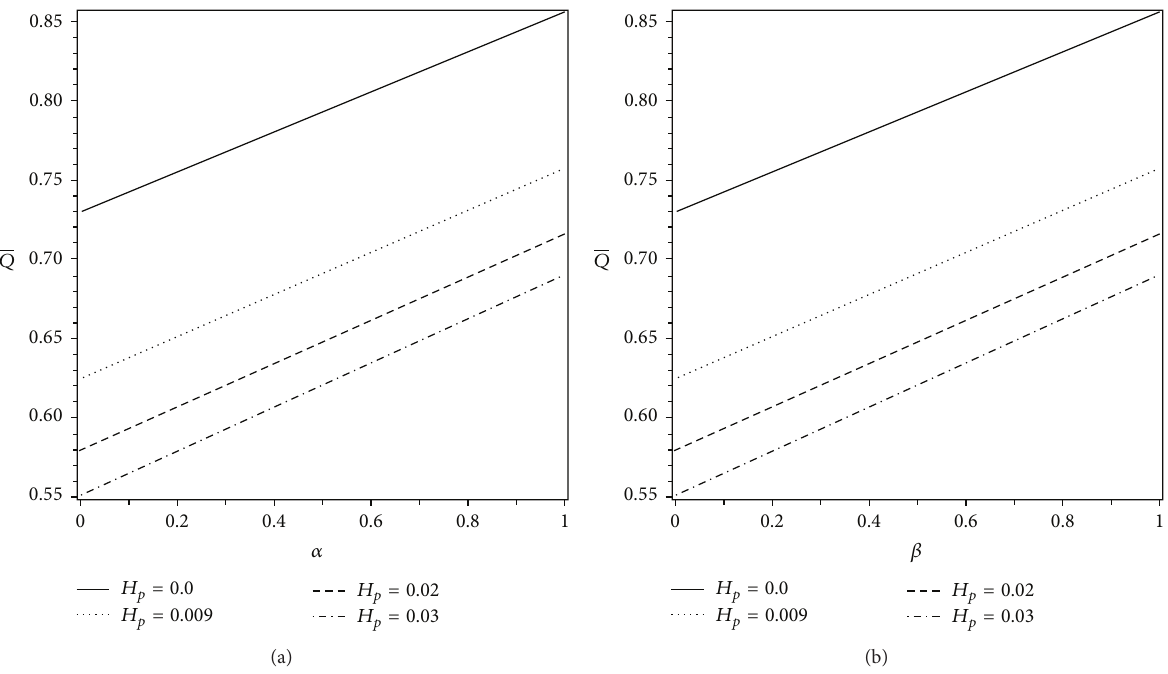
Figure 5: Variations of 𝑄 for different values of 𝐻 𝑝 with (a) 𝛼 when 𝛽 = 0.4 and (b) 𝛽 when 𝛼 = 0.4 . The other parameters are 𝜀 = 0.25 and Δ𝑝 = −5.5